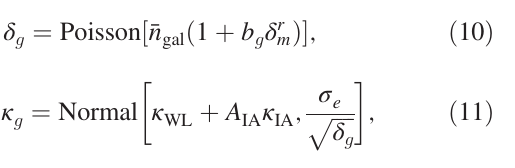
FIG. 1. Example maps for weak lensing convergence κ 5 × 5 deg. The maps were smoothed with the redshift bin-dependent Gaussian kernel, with FWHM corresponding to ∼ 4 Mpc = h at the mean redshift of the bin for weak lensing and ∼ 8 Mpc = h for galaxy clustering (see Sec. II